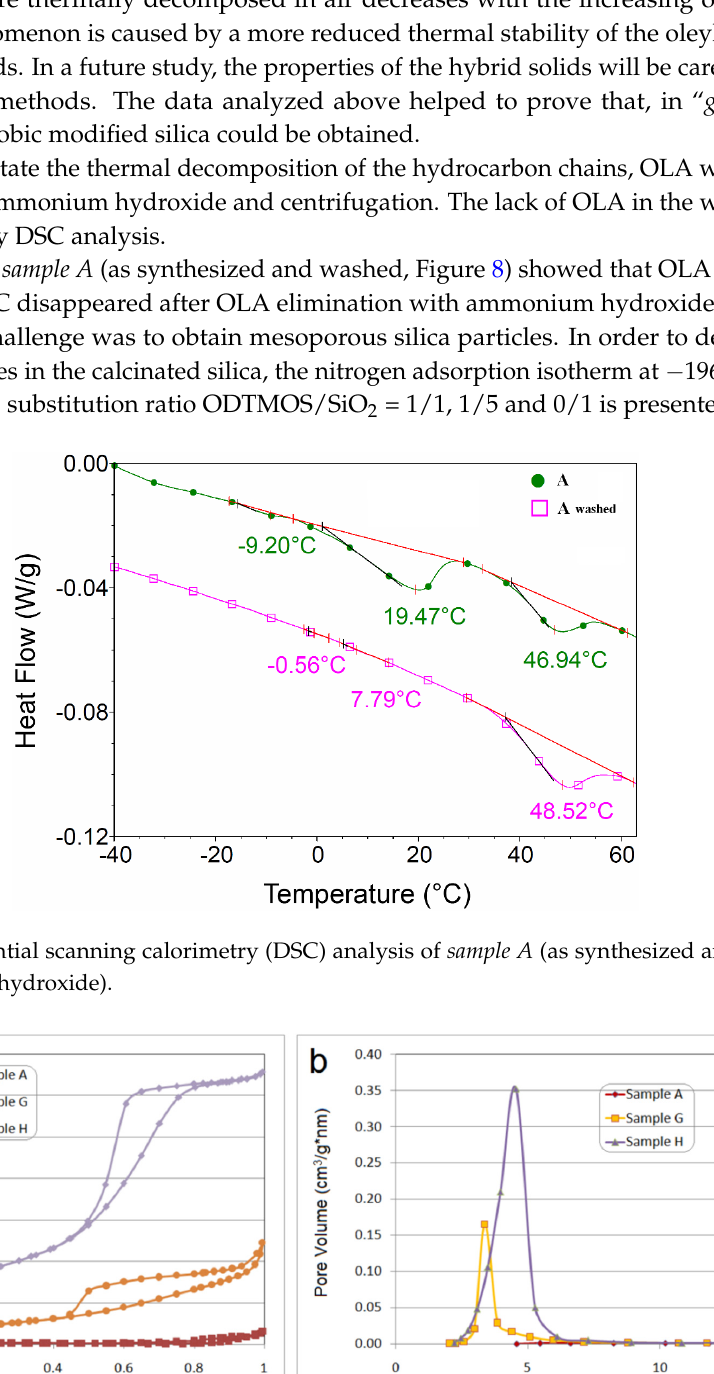
Figure 9. ( a ) Nitrogen isotherms for calcined samples ( A , G and H ); ( b ) Barrett-Joyner-Halenda (BJH) desorption dV/dD pore volume for A , G and H samples (OLA/ Na = 2/1; ODTMOS /SiO 2 = 1/1, 1/5, 0/1).